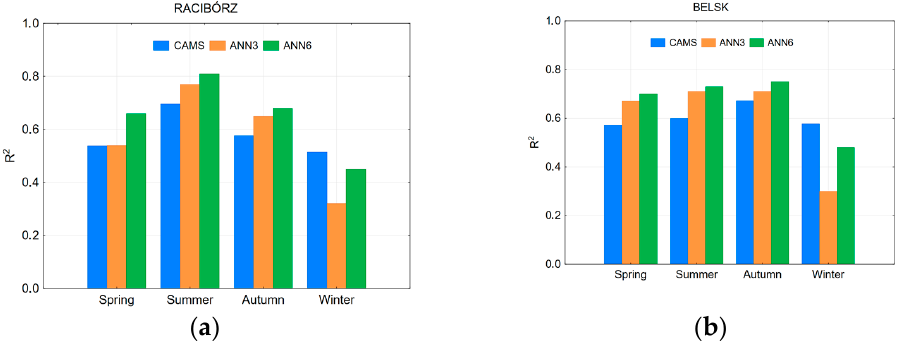
Figure 12. R 2 for the best CAMS forecast, ANN3 and ANN6 for Racibórz ( a ) and Belsk ( b ).